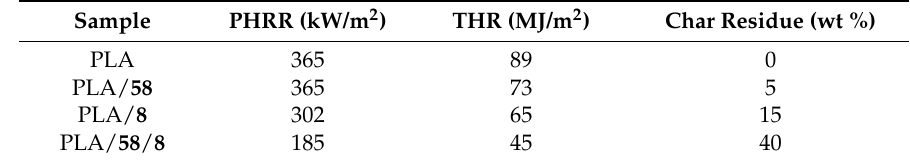
Figure 23. Preparation of 58 . Table 12. Thermal properties of PLA composites of 58 and 8 .